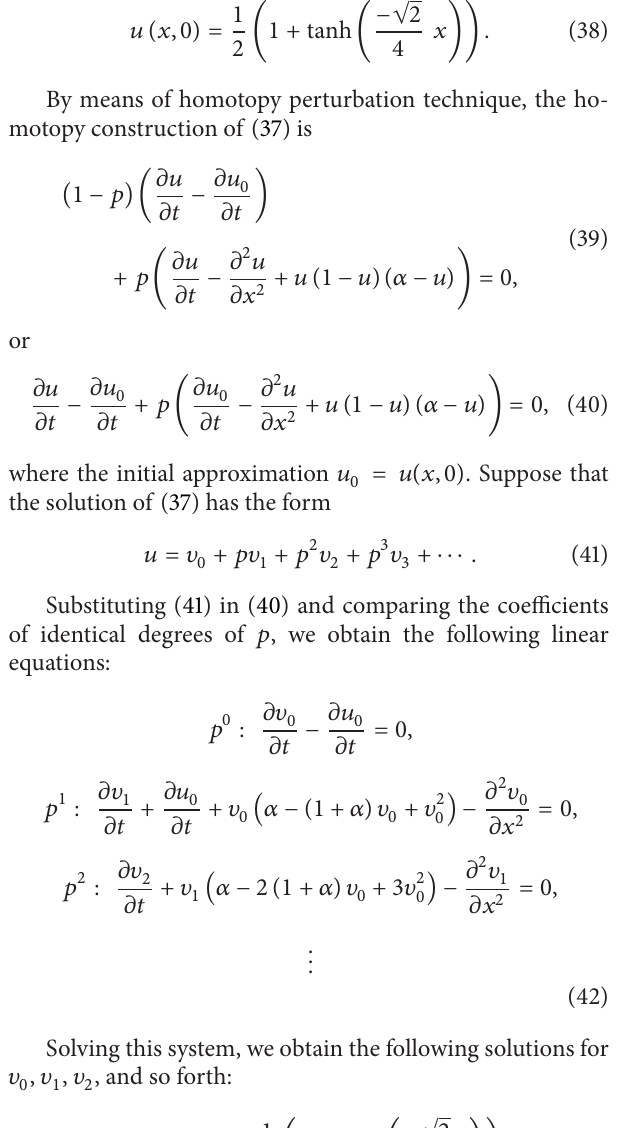
Table 2: Absolute error |𝑢(𝑥,𝑡) − 𝑢 𝑛 = 8 , 𝛼 = 1 .